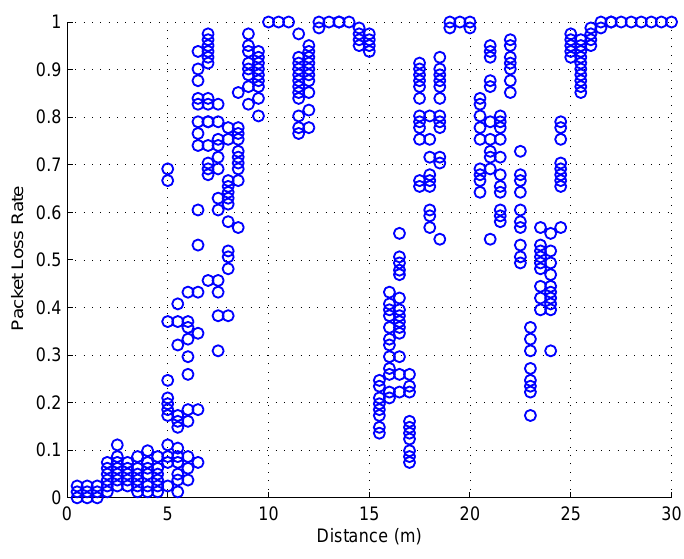
Figure 5. Packet loss rate vs. distance